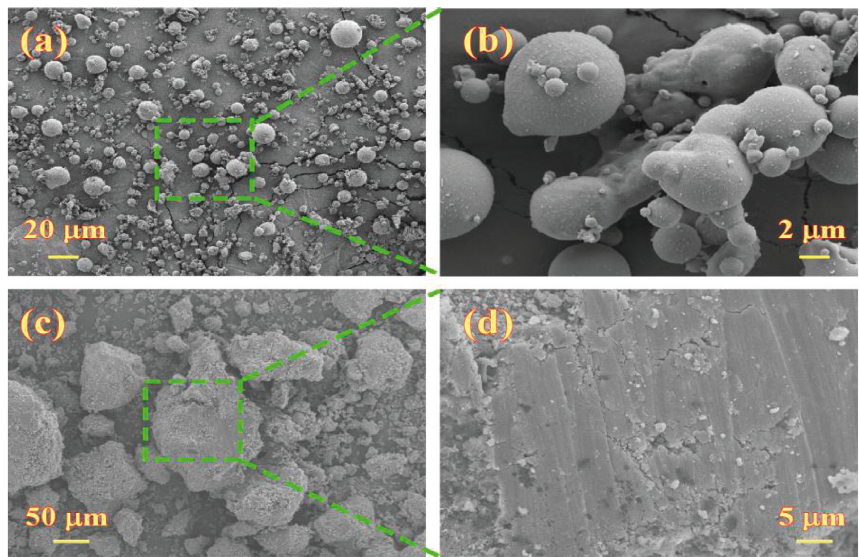
Figure 3: SEM images of (a, b) coal ash and (c, d) sewage sludge.